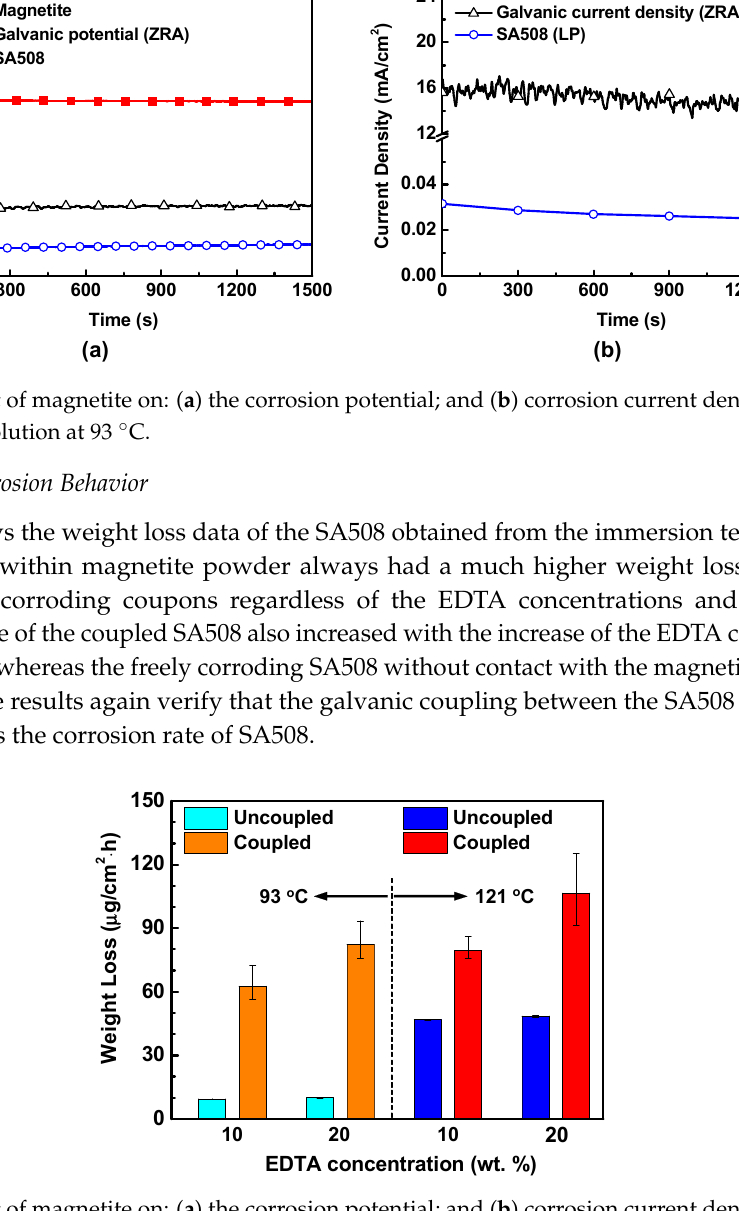
Figure 8. Effect of magnetite on: ( a ) the corrosion potential; and ( b ) corrosion current density in 10% EDTA-based solution at 93 °C.